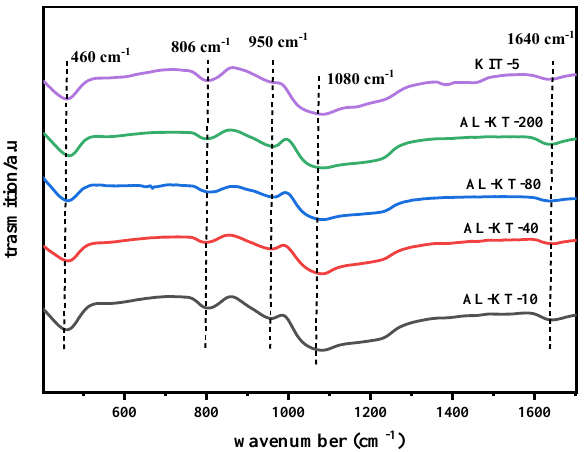
Figure 3. Fourier transform infrared (FTIR) spectra of the KIT-5 support and the Al-KT-X supports.